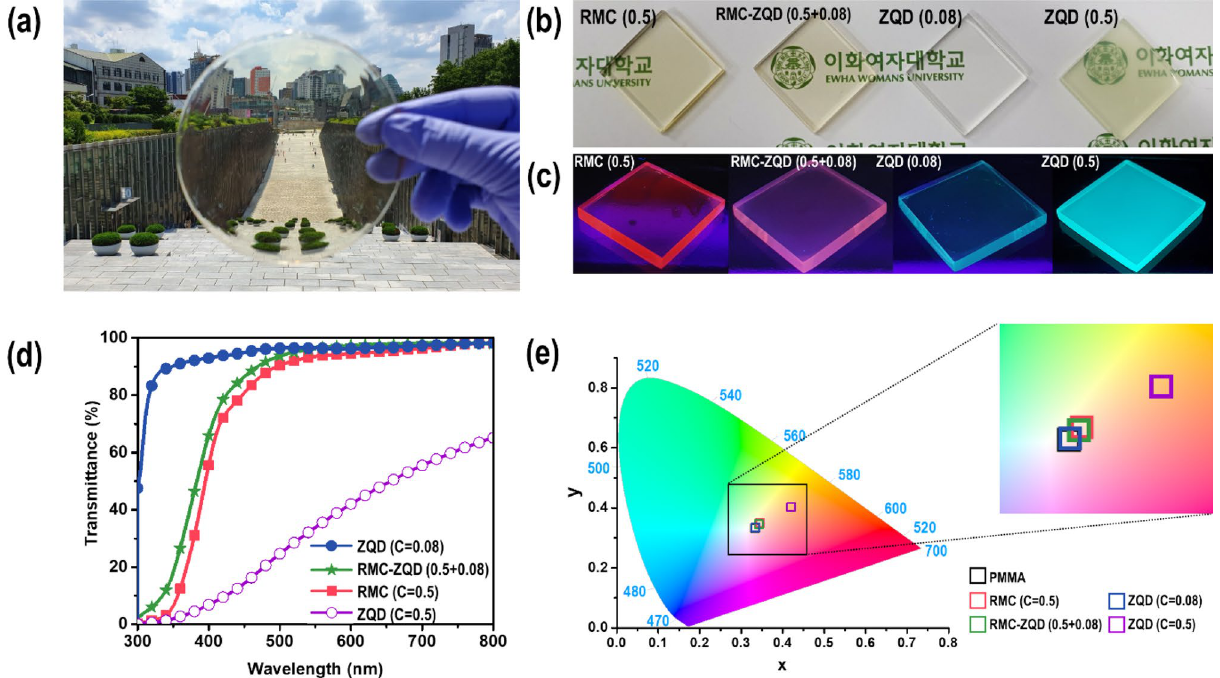
Figure 3. ( a ) Image of the 12-cm-diameter LSC fabricated with dual dyes (RMC and ZQD). ( b ) Photos of the LSC with RMC and ZQD as single luminophores and LSC containing dual dyes in daylight. From the left, the LSC contains 0.5 mg/mL of RMC, 0.5 mg/mL of RMC and 0.08 mg/mL of ZQD, 0.08 mg/mL of ZQD, and 0.5 mg/mL of ZQD. All LSC plates measure 2.5 cm × 2.5 cm × 0.3 cm 3 . ( c ) Photos of the same LSCs under UV